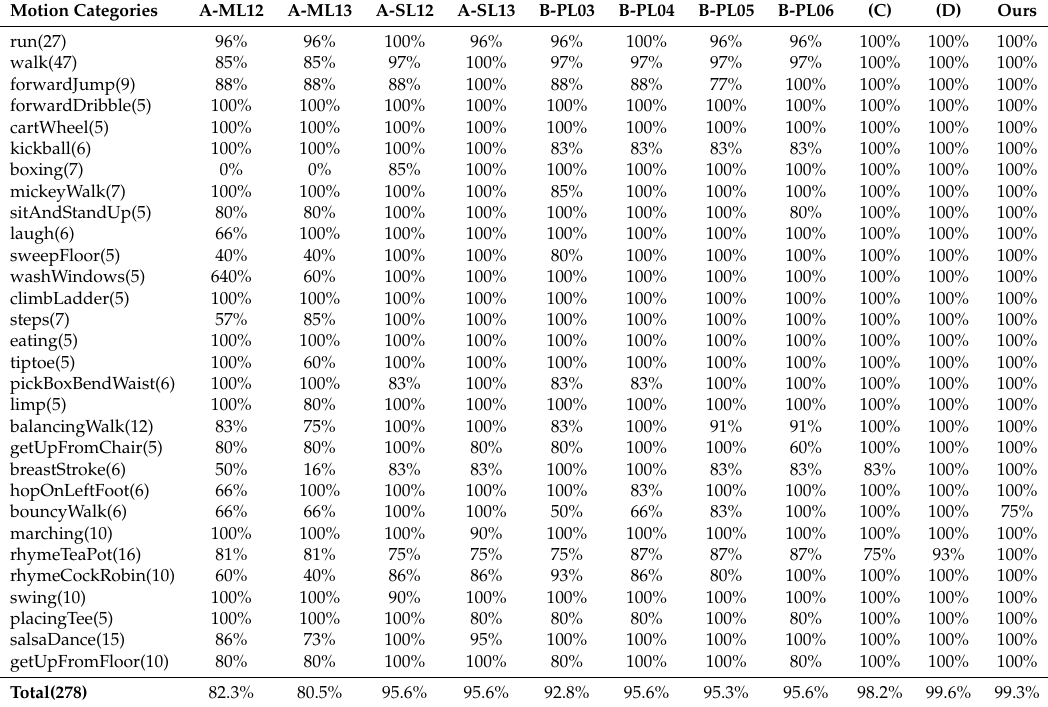
Figure 7. Confusion matrix of our proposed approach on the HDM05-14 dataset. Table 4. A detailed comparison between our approach and other state-of-the-art methods for all 30 motion classes on the CMU-30 dataset. Methods A-ML12 and A-ML13 refer to Max-parameter with Levels 12 and 13, while methods A-SL12 and A-SL13 refer to Sim-parameter with Levels 12 and 13 [37]. Methods B-PL03, B-PL04, B-PL05, and B-PL06 are the Pose histogram with Levels 03, 04, 05, and 06, respectively [37]. Methods C and D refer to Two-Step Score Fusion and Two-Step Support Vector Machine (SVM) Fusion, respectively